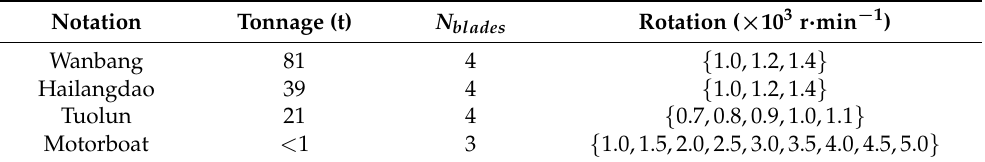
Table 2. Information of ships in the lake trial.